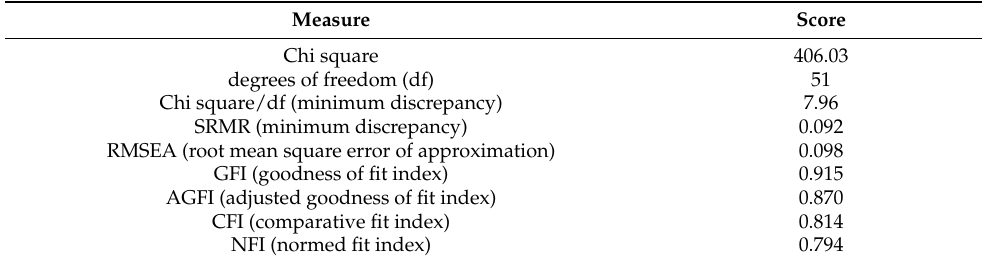
Table 6. Characteristics and goodness-of-fit statistics for the three-factor CFA model.